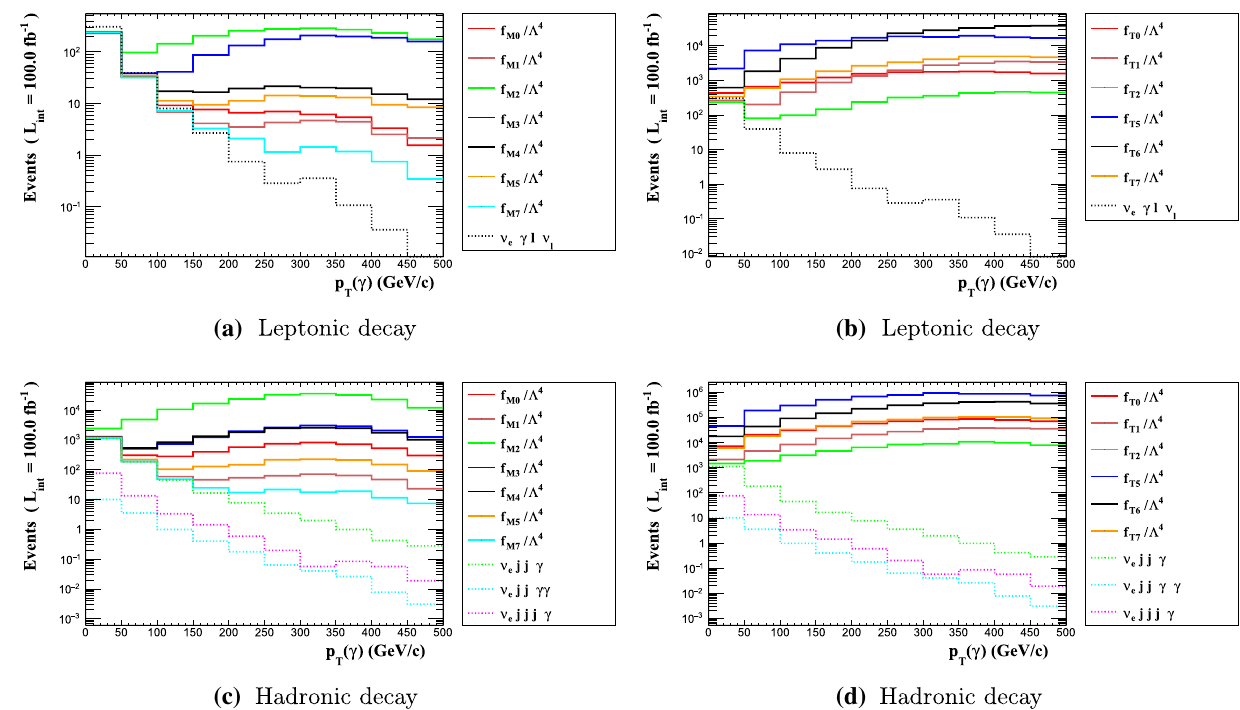
γ pho- tributions are for f M , i /(cid:4) 4 with i = 0 , 1 , 2 , 3 , 4 , 5 , 7, f T , j /(cid:4) 4 with T j = 0 , 1 , 2 , 5 , 6 , 7 and various backgrounds for both leptonic √ s = 3 . 46 TeV. The dis-